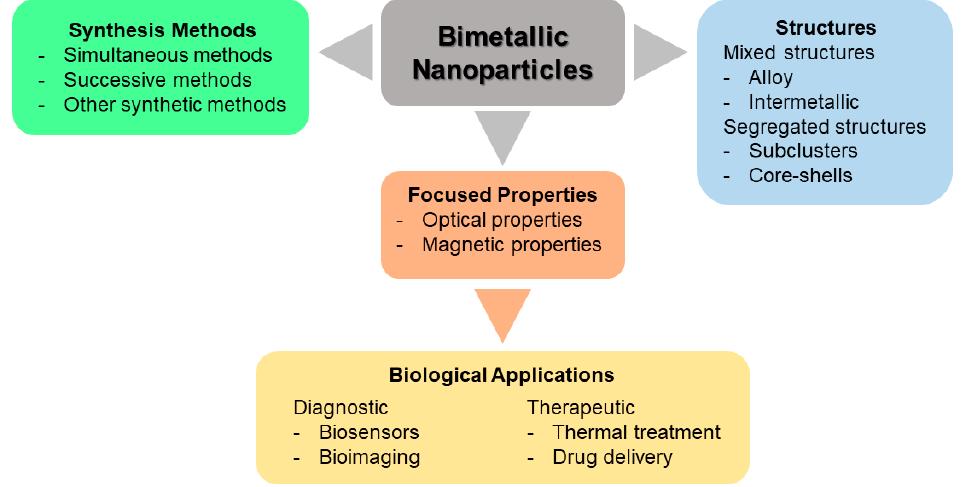
Figure 1. The synthesis and properties of bimetallic nanoparticles for biological